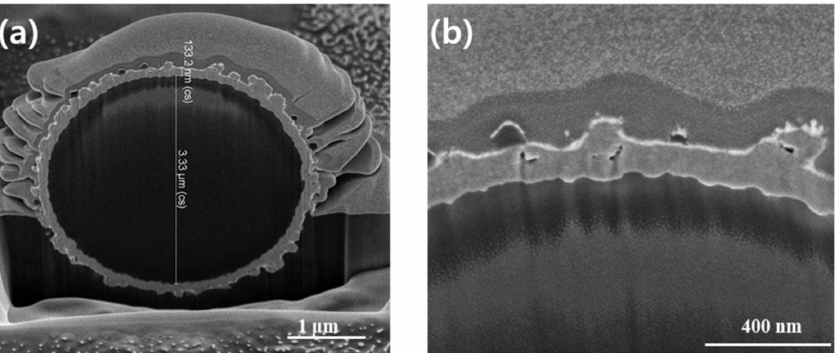
Figure 11. Metal-coated polymer, cross-sectional image: ( a ) image taken at 25 K magnification and ( b ) image taken at 100 K